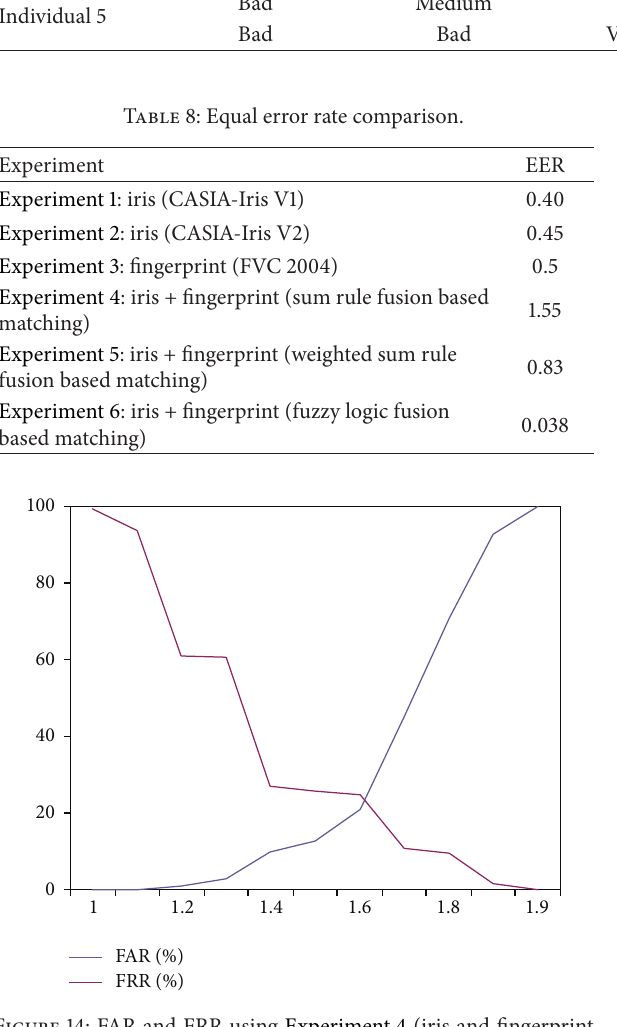
Figure 14: FAR and FRR using Experiment 4 (iris and fingerprint fusion based sum rule matching).